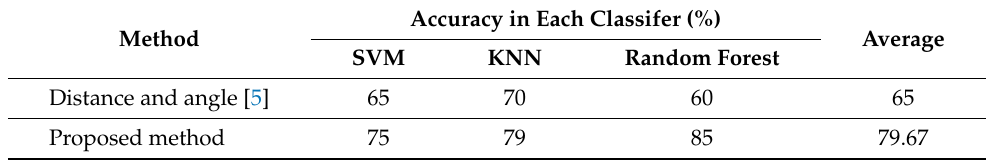
Table 7. Loitering detection method accuracy